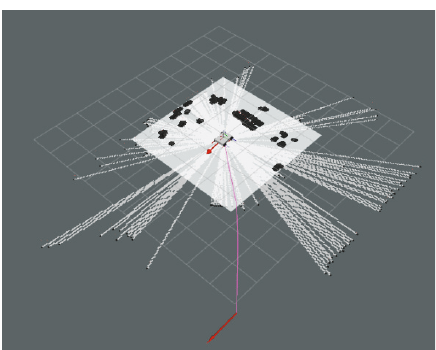
Figure 8: The schematic of global path planning in unknown environment.